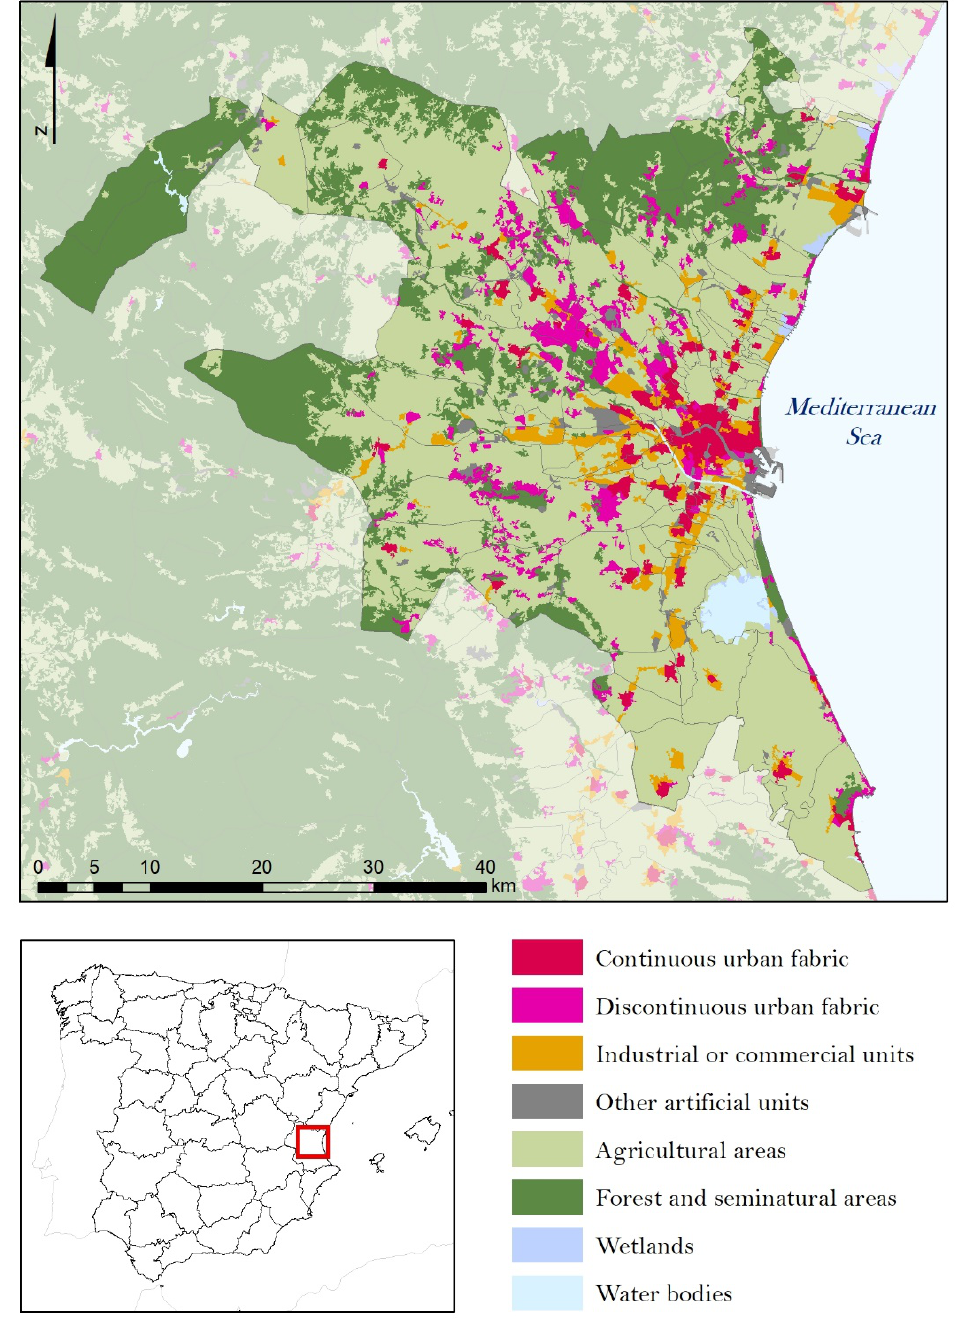
Figure 1. Land uses and location map